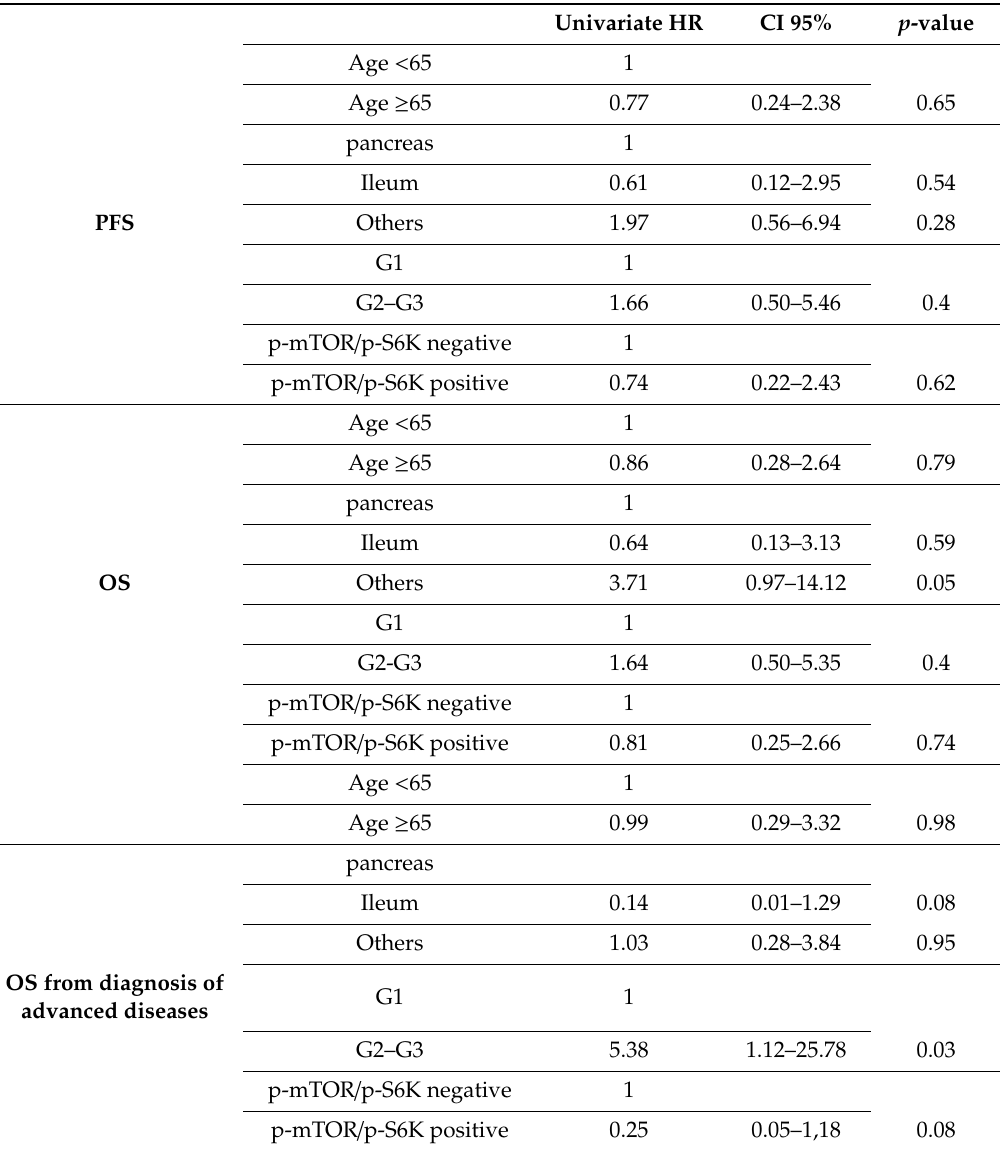
Table 2. Univariate Cox regression analysis.